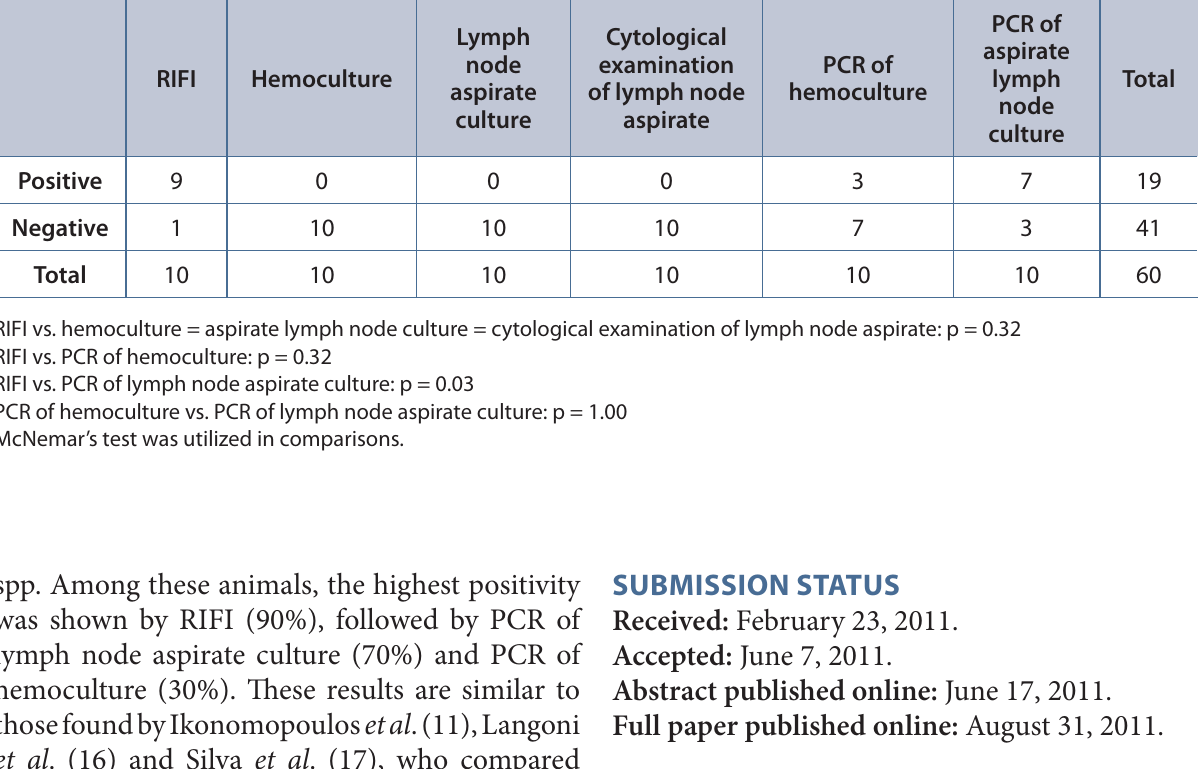
Table 2. Comparison of diagnostic tests in animals infected with Leishmania sp.